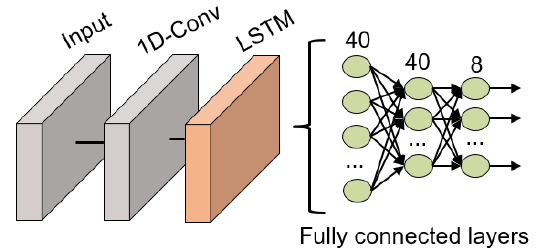
Figure 12. 1D-ConvLSTM NN structure for gesture